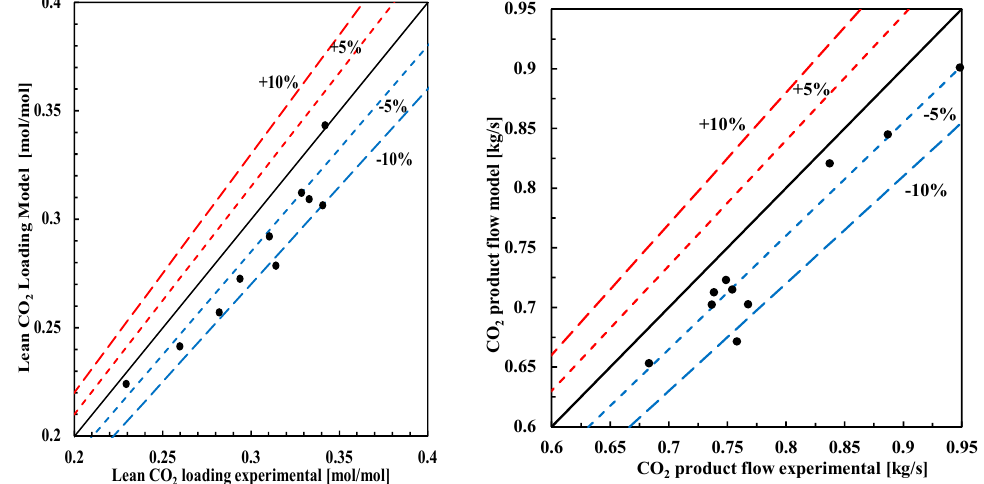
Figure 2. Parity plots of lean CO 2 loading ( left ) and CO 2 product flow rate ( right ). Lines for +10%, +5%, − 5% and − 10% percentage error are shown. The mean percentage error is <6.6% for CO 2 lean loading and <5.3% for product CO 2 flow rate ( F prod ). Energies 2017 , 10 , x FOR PEER REVIEW